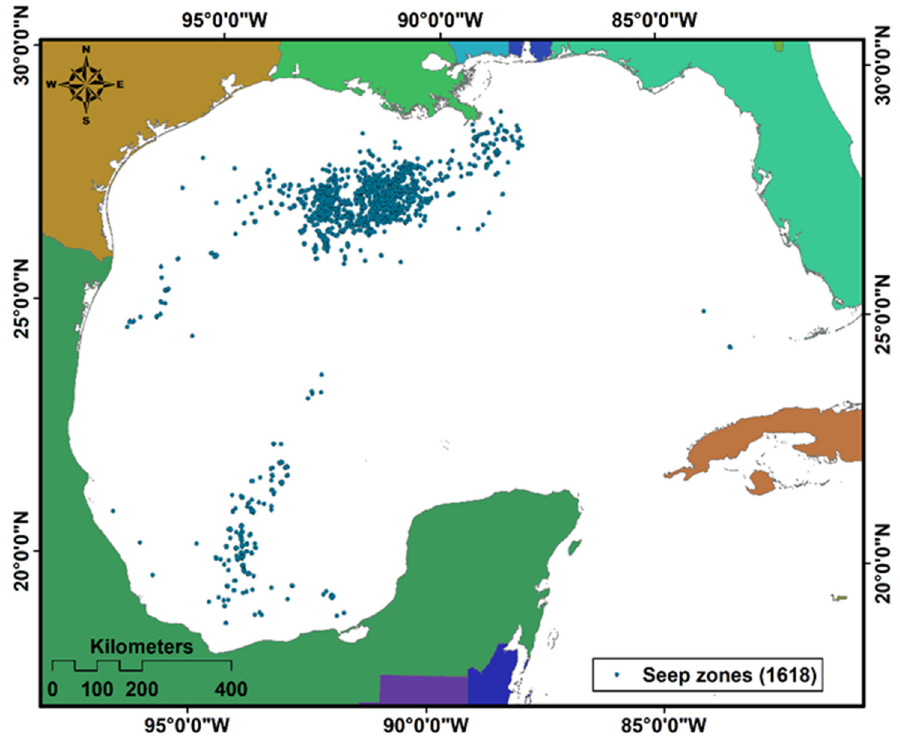
Figure 4. Centroids of seep zones identified using point aggregation.